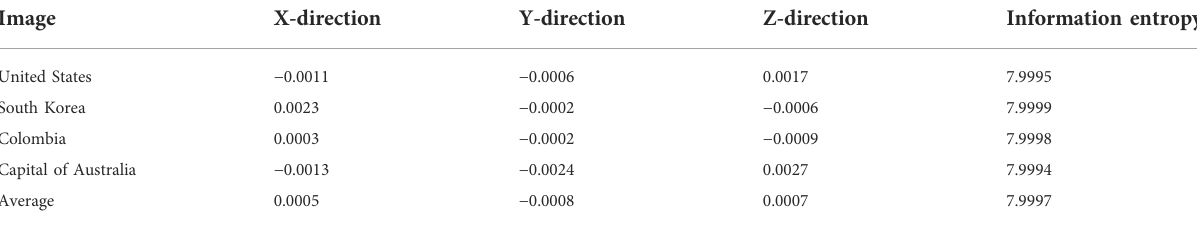
TABLE 9 Replace 1D-SMCLM with sin map in SMCLM-3ME.